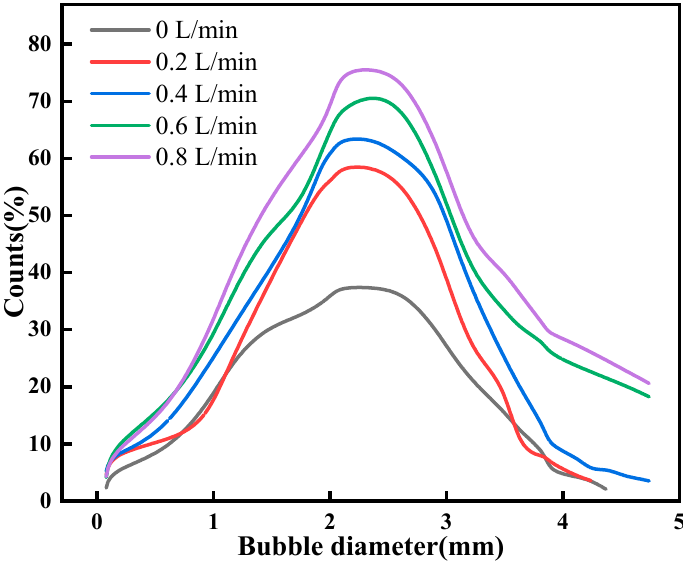
Figure 9. The surface particle size of bubbles at different flow rates.